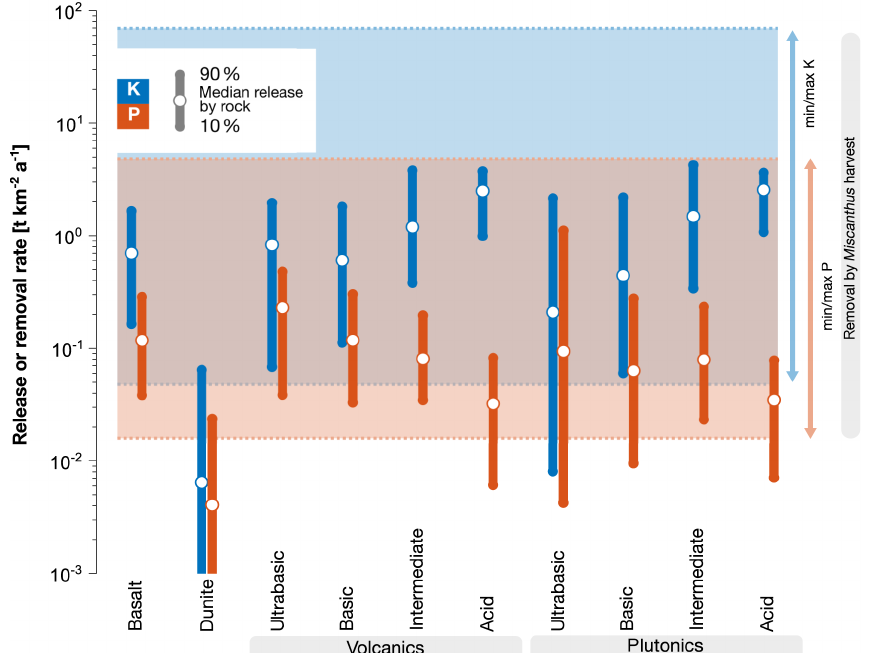
Figure 3. Weathering release rates (circles; bars as variability indicator) of P and K from selected rocks (assuming their full dissolution under a natural subtropical weathering scenario) and extraction of those nutrients by harvesting Miscanthus energy grass (blue and red areas indicate range between min. and max. nutrient content of different Miscanthus species multiplied by min. and max. yield reported in Brosse et al. (2012), Tables S2-1 and S2-2). Details on rock dissolution and nutrient release rates in Sect. S6 and on plant nutrient removal and additional Miscanthus data on major crops in Sect. S2. Dunite values for the 10th percentile were cut off for better overall